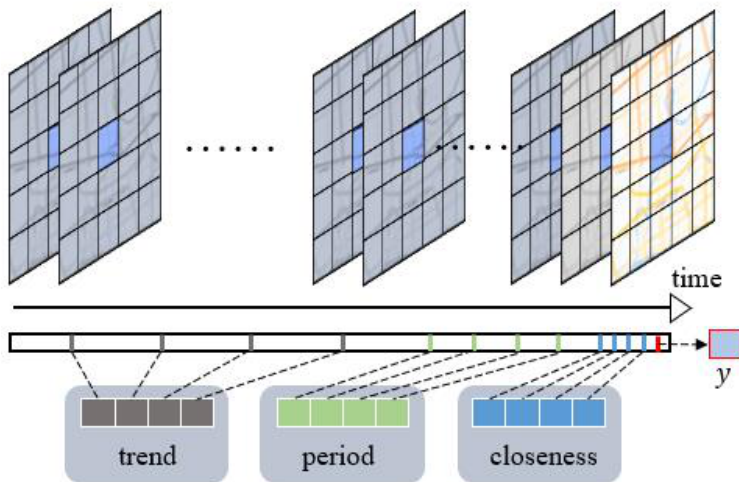
Figure 6. Periodicity of a certain location.